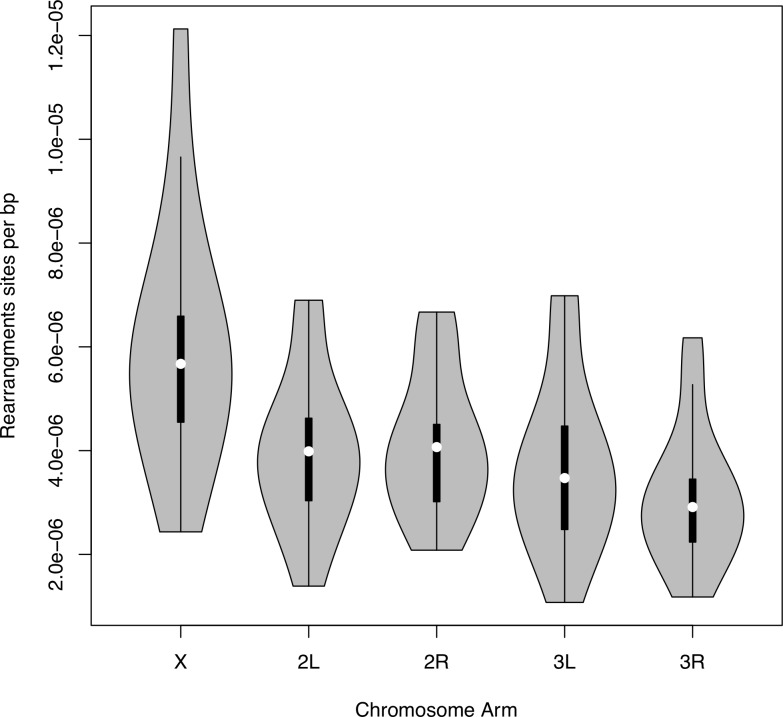
Number of rearrangement breakpoints per base pair on each chromosome arm for inbred lines of D. yakuba.Total number of rearrangement sites on each chomosome varied (ANOVA, F(4,52) = 43.42, P<10−15). This is mostly do to the the fact that the X chromosome has significantly more rearrangement breakpoints than the autosomes (Tukey HSD for each comparison involving the X, P<10−6). Chromosome 3R had significantly fewer rearrangements than the X, 2L and 2R (Tukey HSD, P < 0.05).